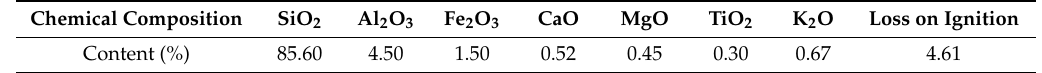
Figure 3. Images of basalt fiber. ( a ) Morphology of basalt fiber; ( b ) SEM images of basalt fiber. Table 3. Diatomite chemical composition.